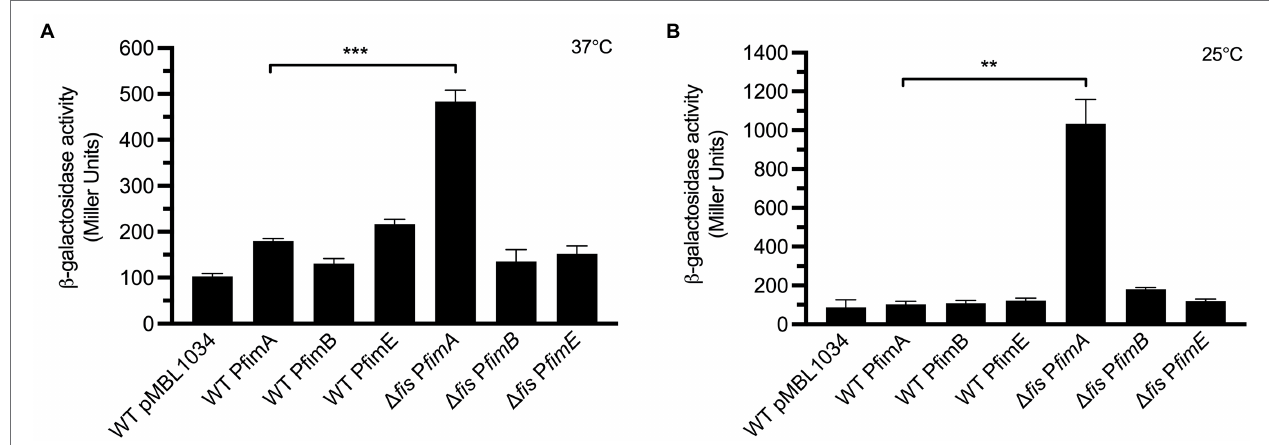
FIGURE 5 | Analysis of transcriptional expression. Fusion constructs consisting of fimA , fimB , and fimE promoters fused to the promoter-less β -galactosidase reporter gene were employed to quantitatively determine the expression of fim promoters. (A,B) A 3-fold and 10-fold increased activity of the P fimA promoter in the E2348/69 Δ fis was recorded at 37 ° C and 25 ° C, respectively, in comparison with the wild-type strain. No transcriptional activity was seen in the rest of the fusions. E2348/69 and E2348/69 Δ fis carrying pMLB1034 were used as negative controls. These data are the mean of at least three experiments performed in triplicate on different days. ** p < 0.01; *** p < 0.001.